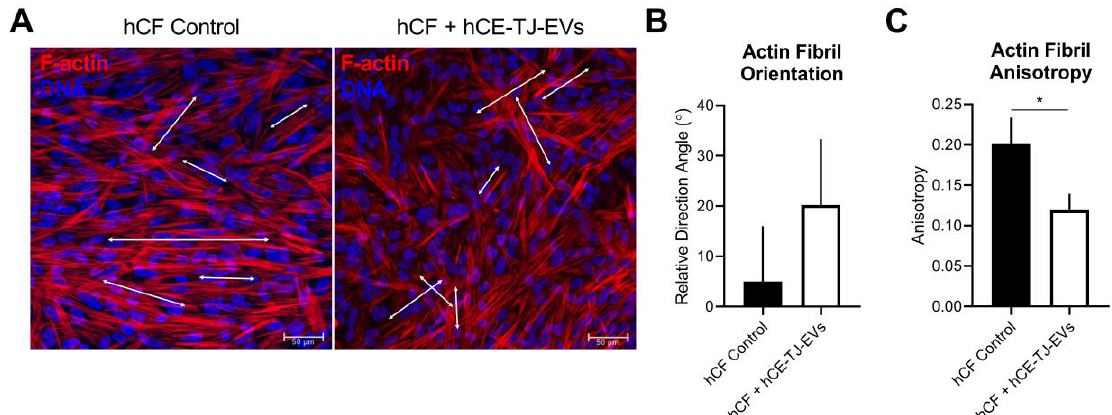
Figure 3. hCE-TJ-derived EVs promote decreased F-actin anisotropy in hCFs based on phalloidin staining. ( A ) Representative immunofluorescence images of hCF controls and hCFs treated with hCE-TJ-derived EVs. Then, 25 μg/mL of EVs were applied to each sample. Arrows depict the relative orientation and directionality of select actin fibrils within each group. Phalloidin (F-actin) = red; Nuclei (DNA) = blue. Scale bars = 50 μm . ( B ) The total actin fibril organization and ( C ) actin fibril fractional anisotropy quantified using the ImageJ plug-in, FibrilTool. n = 12 for contols and n = 13 for EV-treated groups. Error bars represent SEM. Statistical significance determined using a Mann–Whitney t-test. * p ≤ 0.05.